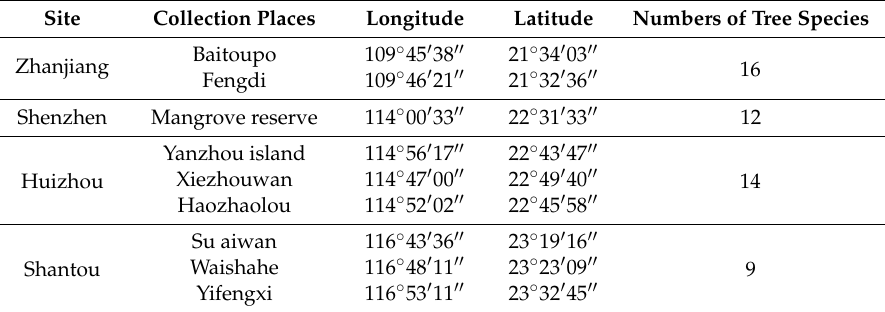
Table 1. The information of mangrove samples collected in the Guangdong